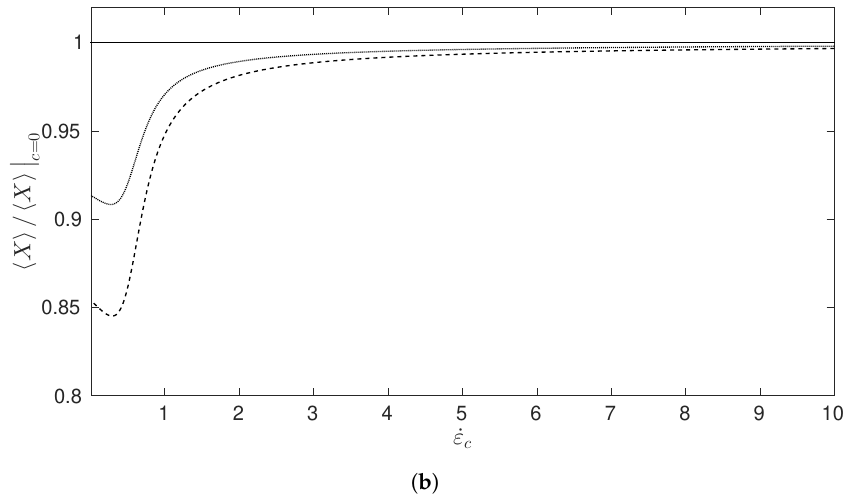
Figure 6. The mean horizontal extension scaled by the infinitely dilute case against ( a ) ˙ ε and ( b ) ˙ ε c from simulations that include the mean-field term. The results are given for c the solid, dashed and dotted lines, respectively.